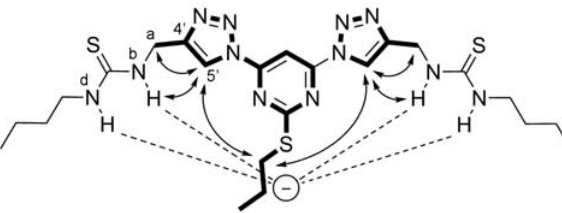
Figure 5. Predominant conformation and position of chloride an- ion in 2 -Cl – complex in acetonitrile-d shift changes and NOESY cross-peaks ( π NOESY correlations are marked with arrows.